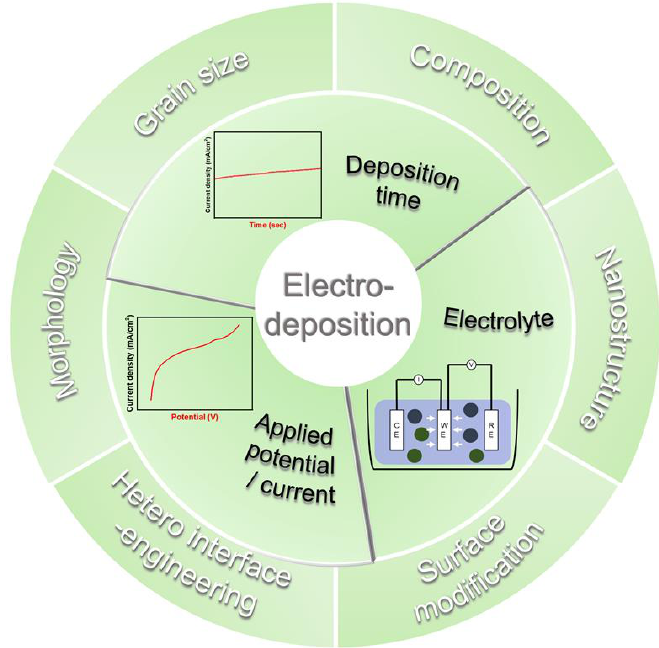
Figure 10. Summary of the various strategies and process variables in electrodeposition to improve water-splitting catalytic performance.